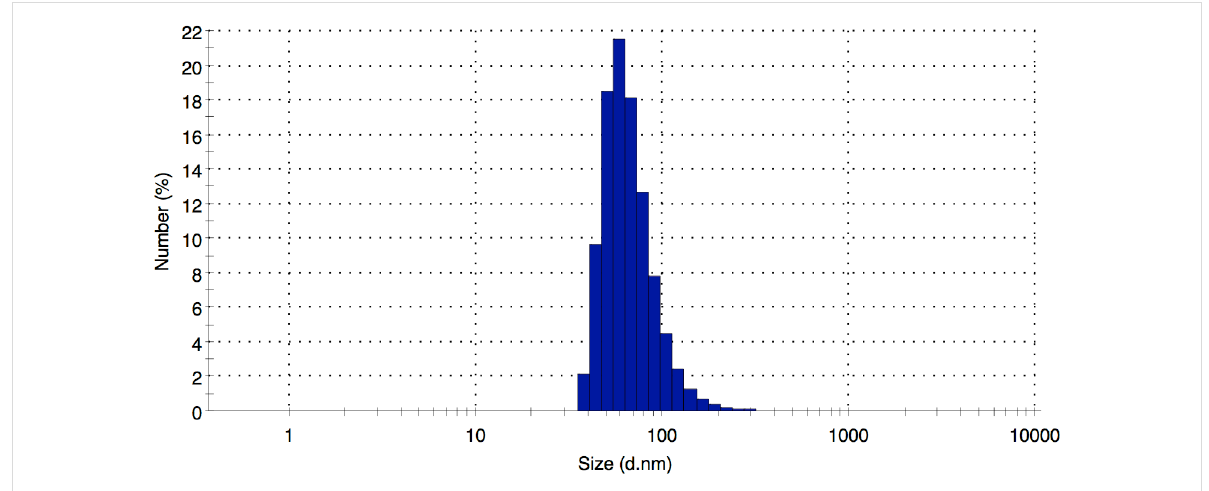
Figure 2: Particle number distribution of PVP-AgNP by dynamic light scattering (Nano Zetasizer ZS, Malvern, Herrenberg, Germany).